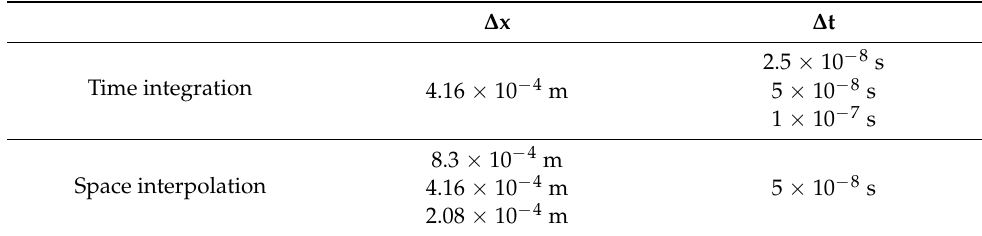
Table 1. Axial grid step and timesteps.